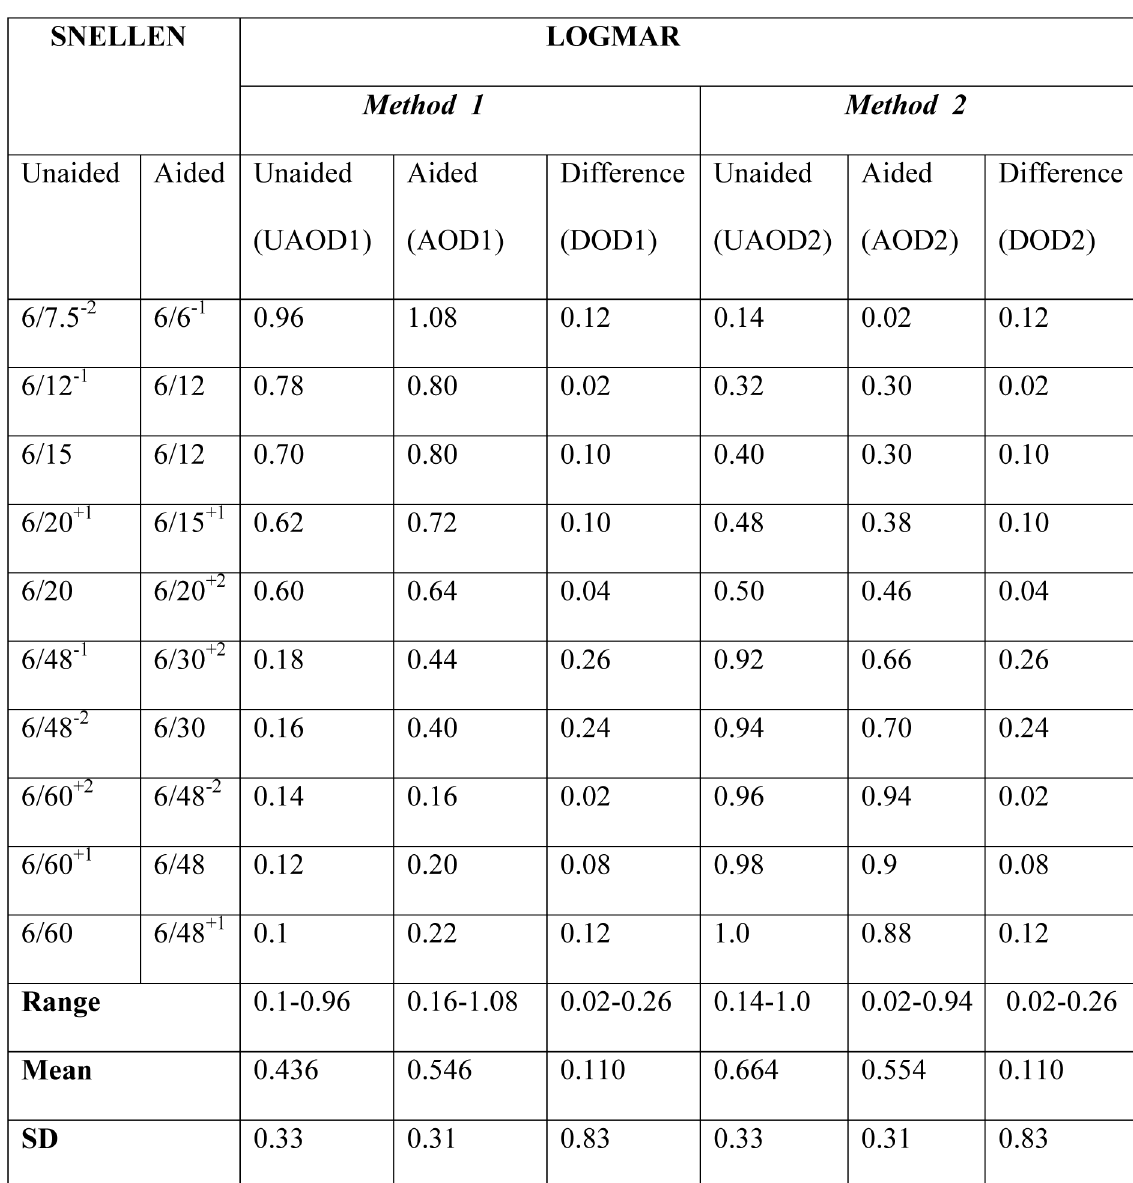
Table 1: Showing the best five and worst five VA raw data (OD) in the study. The differences between the unaided and aided VA for the two methods are shown. The range, mean and SD values for the ten values are